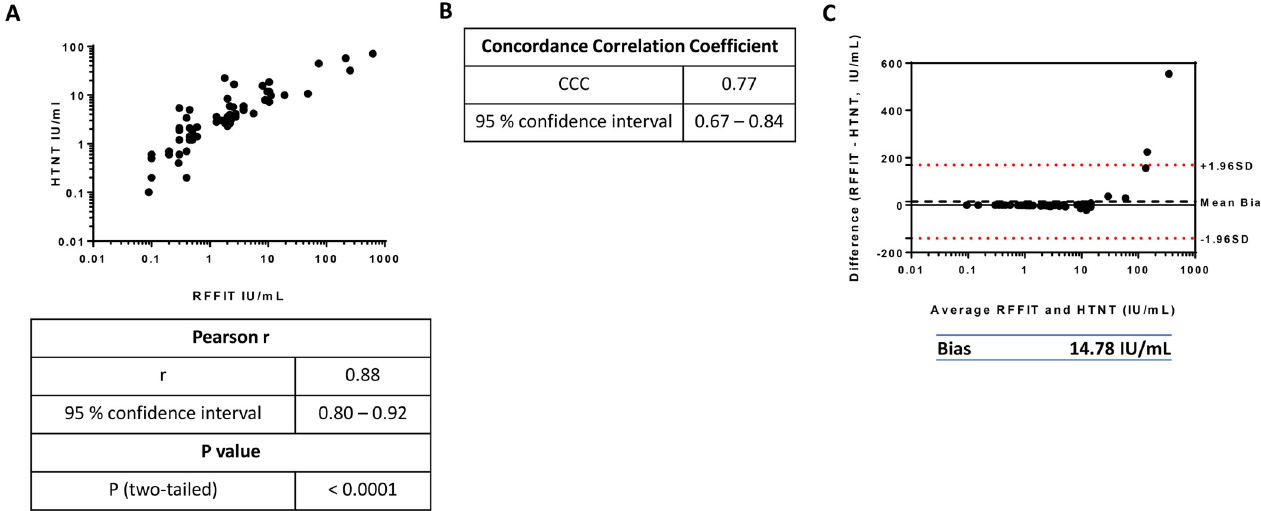
Fig 5. Comparison of HTNT and RFFIT titers of human sera. Titers (IU/ml) of positive human sera were compared between the two methods. Titers were log-transformed for normalization purposes. (A) HTNT titers were plotted against RFFIT titers to determine the Pearson correlation coefficient. Similarly, the concordance correlation coefficient (B) and the Bland-Altman plot of differences (C) were calculated. In (C), the mean difference of the titers is represented by the Bias value, plotted as a black dotted line above 0. The limits of agreement, within which 95% of the differences between RFFIT and HTNT are denoted by the red dotted lines above and below 1.96 standard deviations of the mean